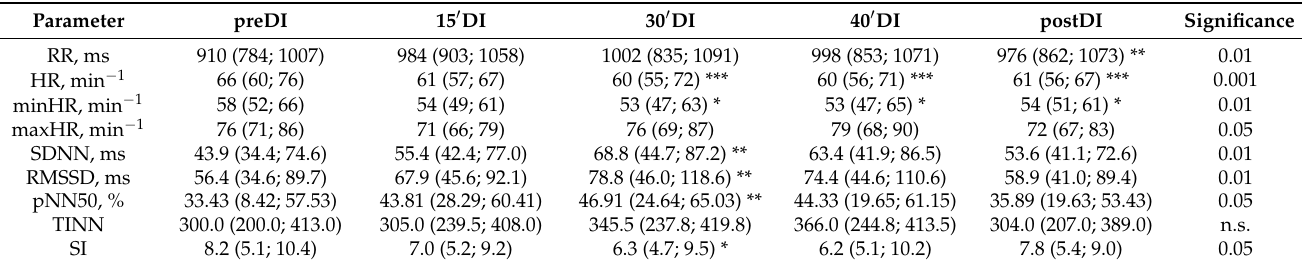
Table 1. Time-domain results of heart rate variability in subjects during DI session.